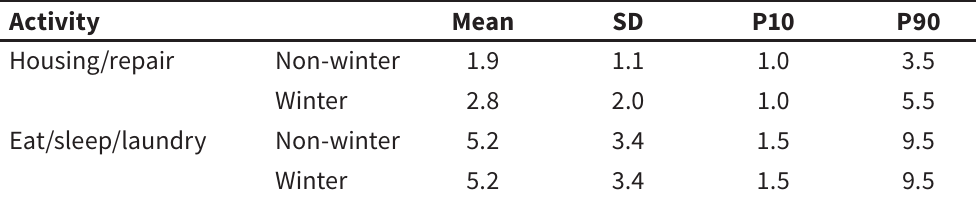
Hours spent on activities per day in colder vis-à-vis other months